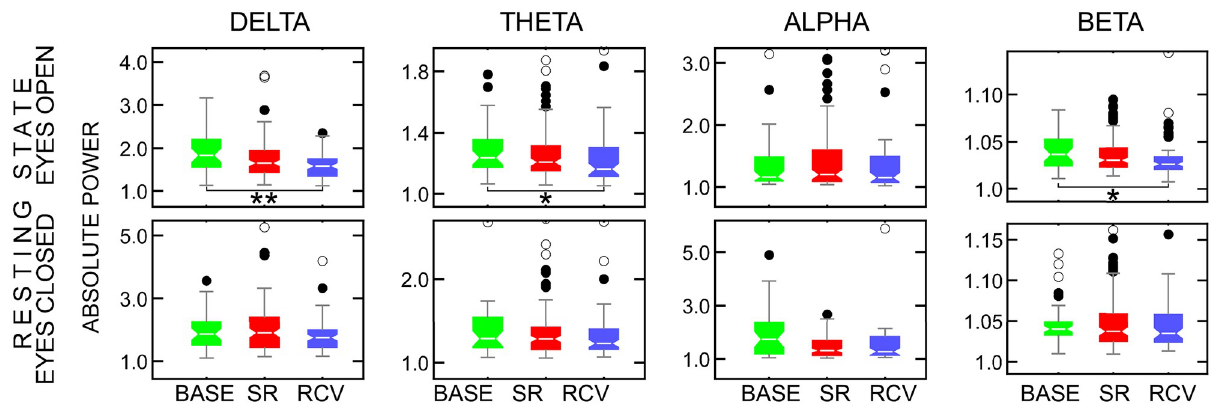
Fig 6. The absolute power of δ (1–4 Hz) (first column), θ (4–8 Hz) (second column), α (8–13 Hz) (third column) and β waves (13–30 Hz) (fourth column) for resting state with eyes open (top row) and closed (bottom row) at Cz electrode. The boxes show median and interquartile range, together with near (full circles) and far (empty circles) outliers. Some extreme outliers are not shown to retain the scale for visibility. Significant differences between conditions are marked with: � p < 0.05, �� p < 0.01.